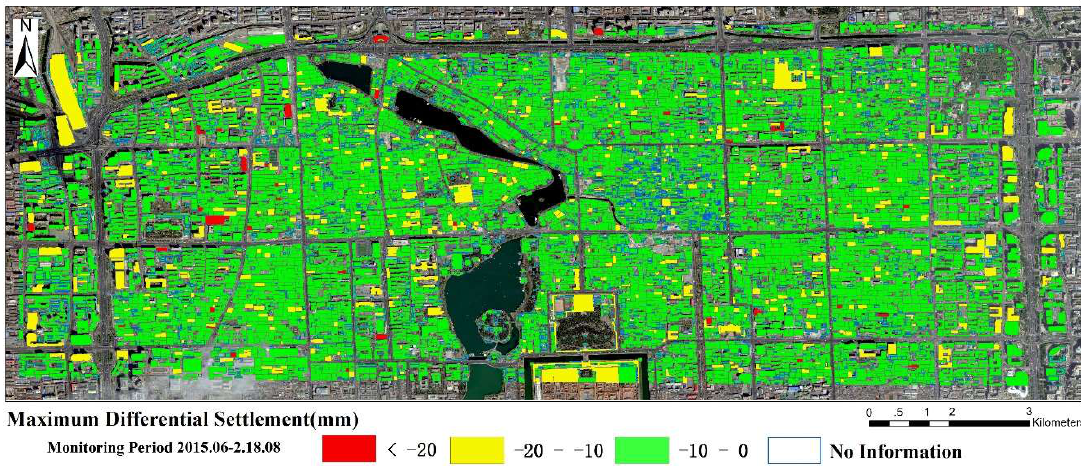
Figure 16. Maximum measured differential settlement values for the buildings in the target area.